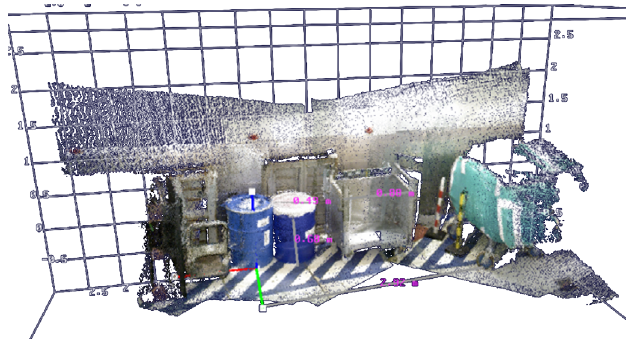
Fig. 9. topographical study interface presenting dimensioning tools.